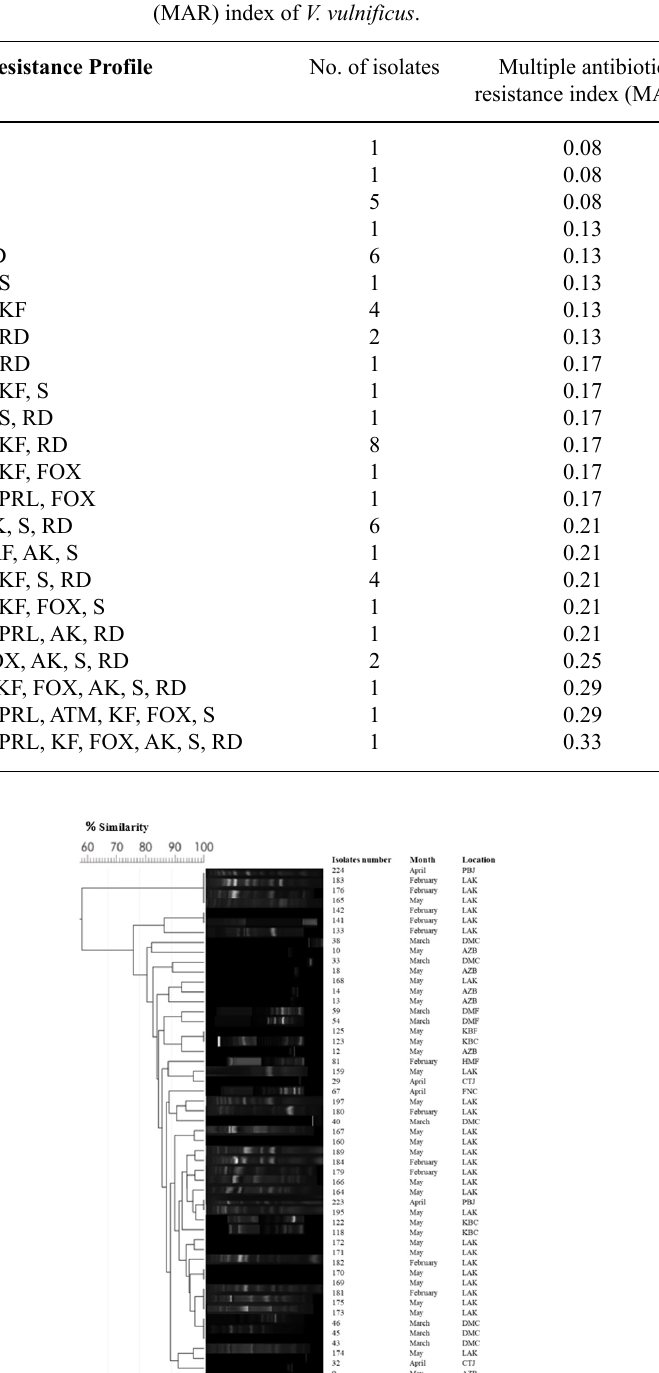
Table 3. Antibiotic resistance profile and multiple antibiotic resistance